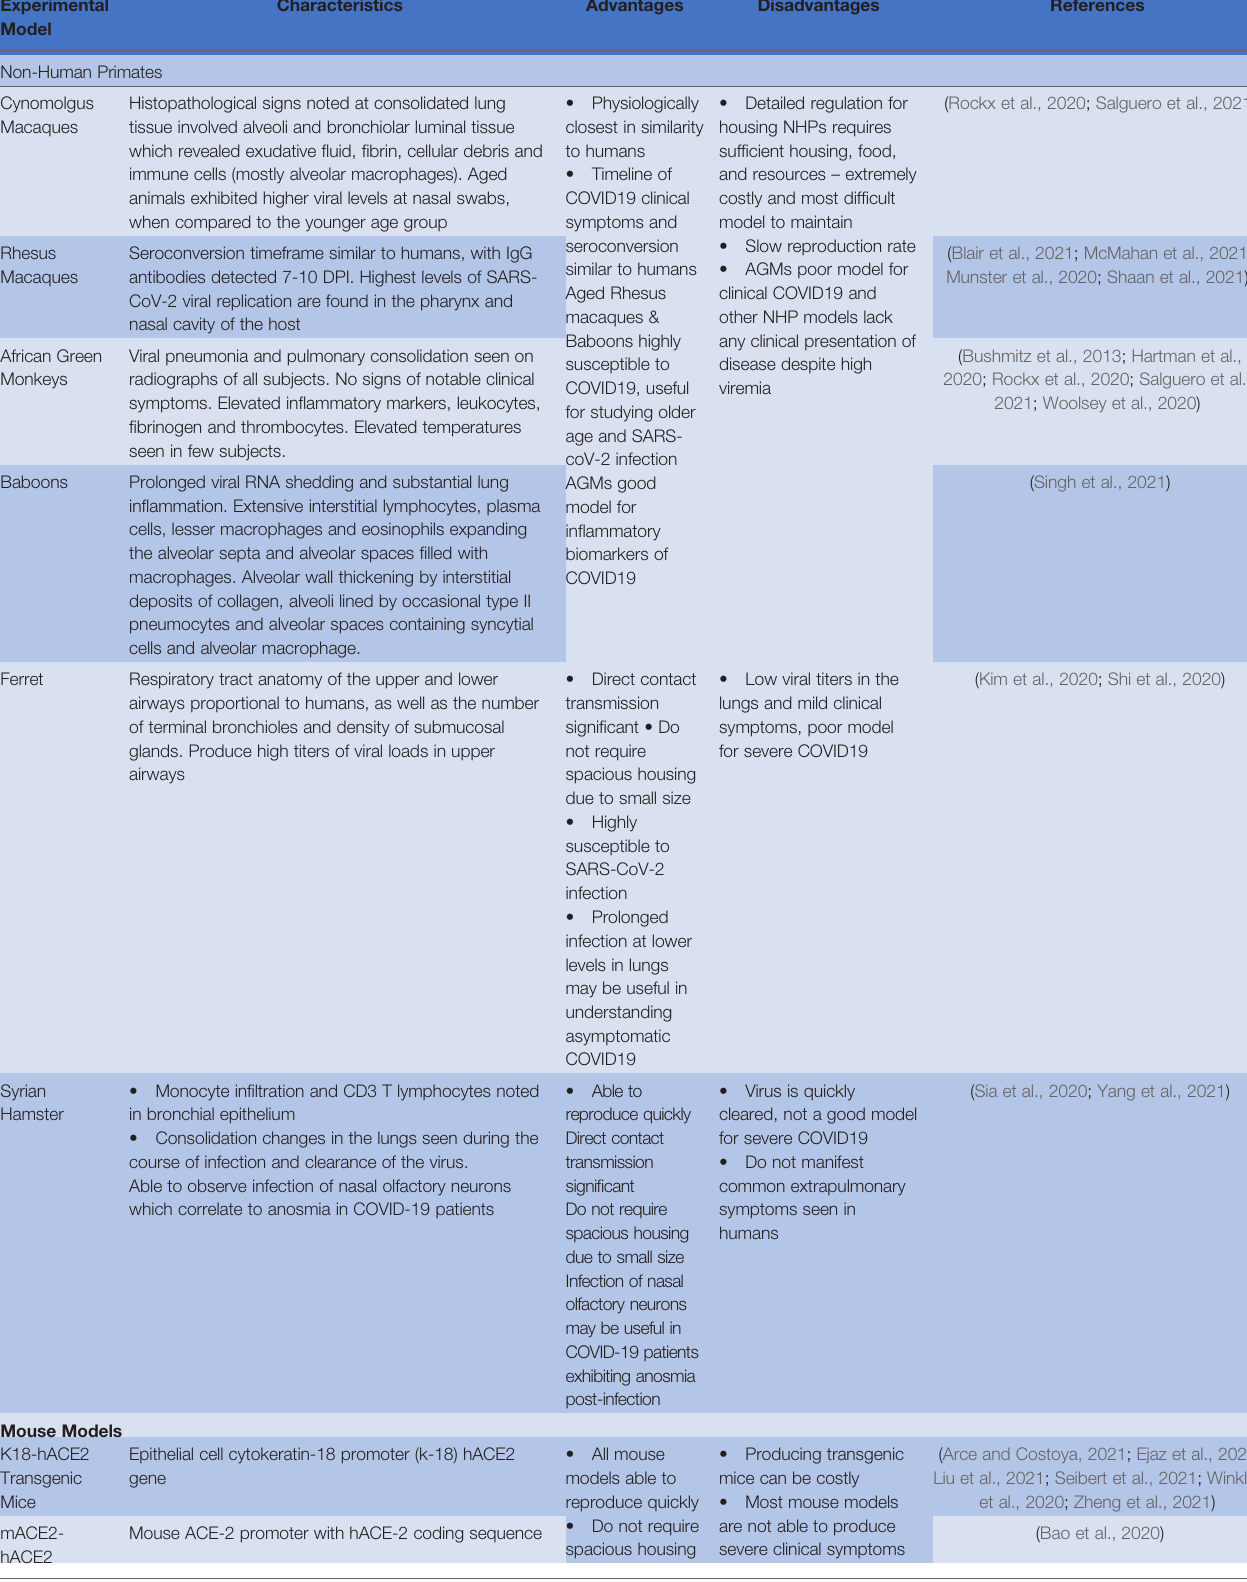
TABLE 2 | Experimental models of SARS-CoV-2 with characteristic features, advantages and disadvantages. Experimental